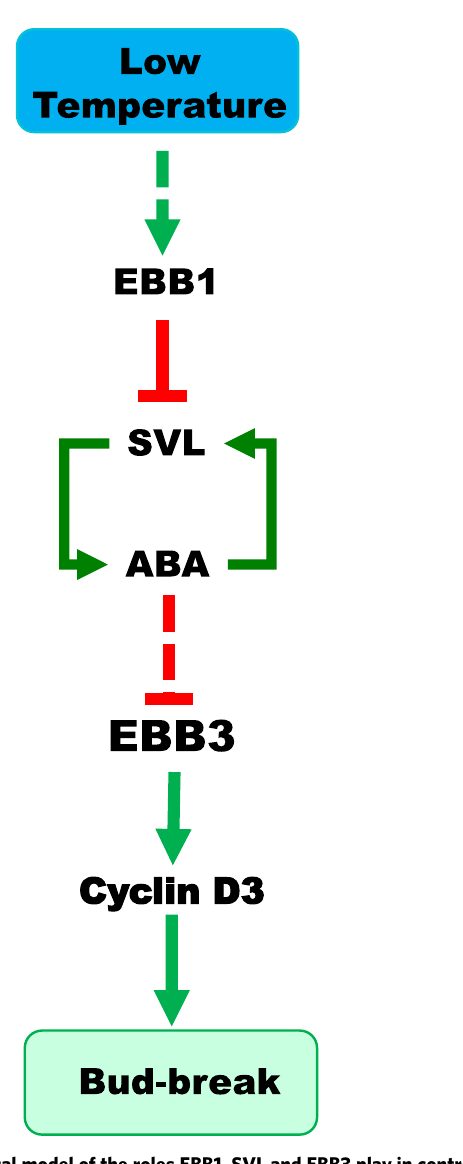
Fig. 7 Hypothetical model of the roles EBB1, SVL and EBB3 play in control of bud-break in poplar. EBB1 is positively regulated by low temperature, leading to suppression of SVL expression. Declining SVL expression breaks the SVL/ABA feedforward loop. SVL/ABA repression leads to the upregulation of EBB3 and consequently to activation of CYCD3.1 , cell proliferation, and bud-break. Green arrows indicate positive regulation while red bars indicate negative regulation. Dash arrows indicate indirect regulation. See the text for additional